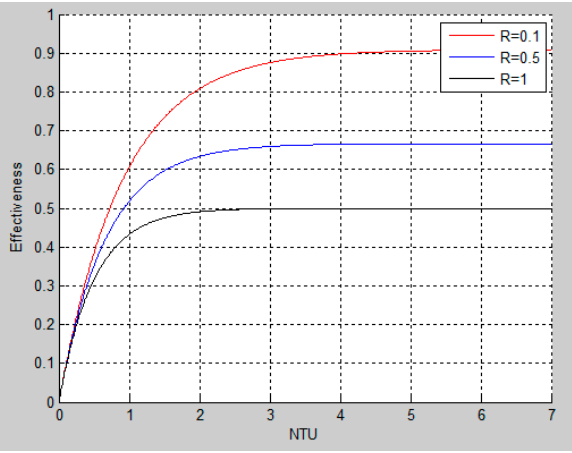
Figure 5. Relations between NTU and R values in a plate heat exchanger.